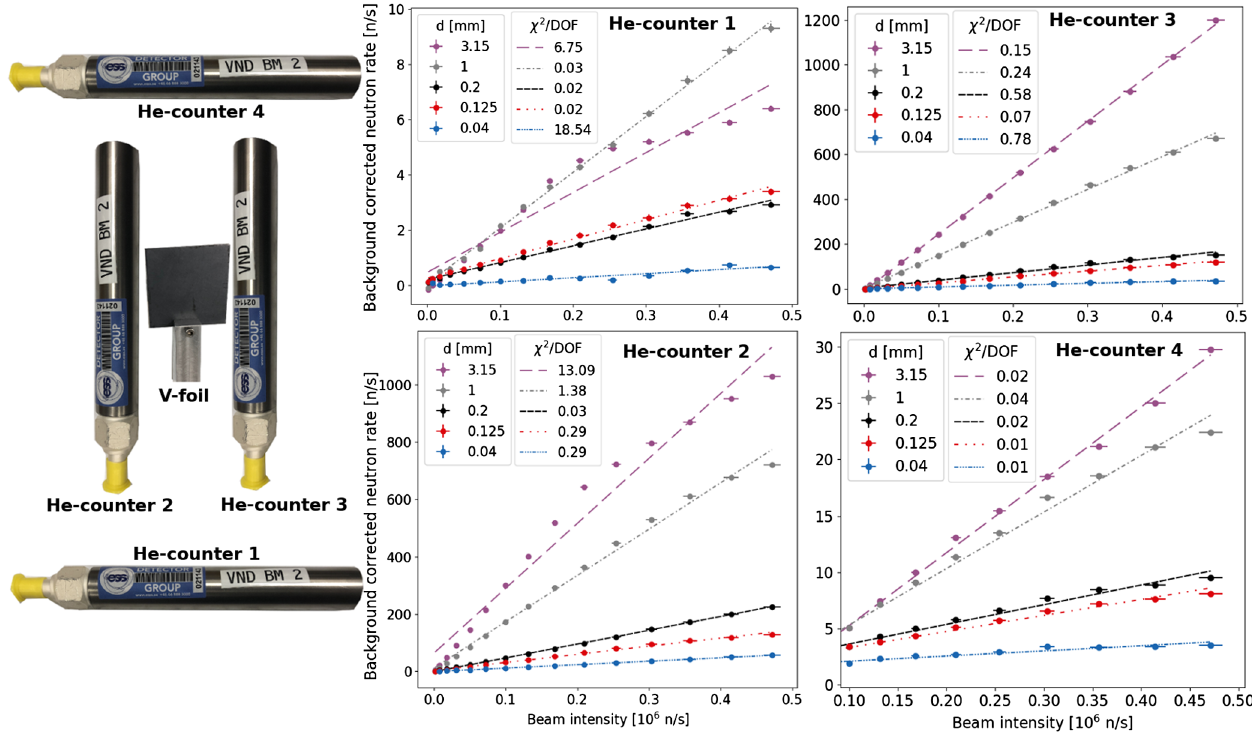
FIG. 10. Left: Photo of the four different He-proportional counters placed around the vanadium foil at V17. Right: Four graphs corresponding to 4 different He-proportional counters placed around the vanadium foil at V17. The efficiency and therefore the flux limitations are changing with varying distance of the 3 He proportional counter from the center of the vanadium